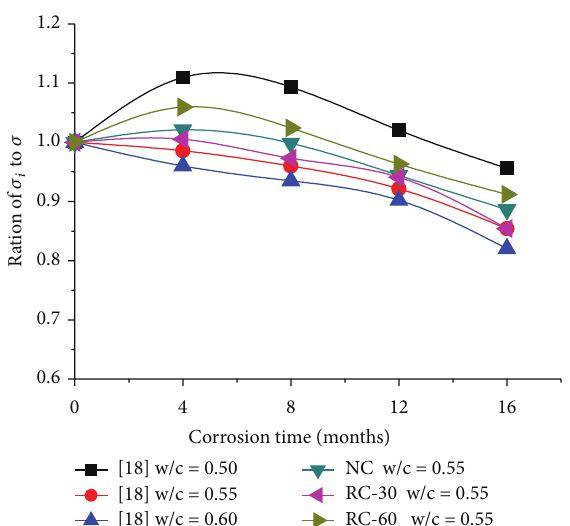
Figure1:DimensionsofcompressivestrengthofRACwithprevious research.